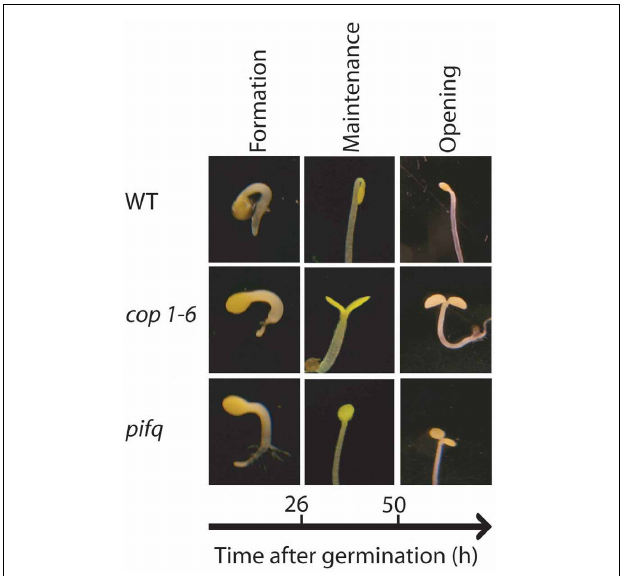
FIGURE 1 | Apical hook development in dark grown seedlings requires the repressors of photomorphogenesis COP1 and PIFs. Representative photographs of the apical section of the hypocotyls of WT Col, cop1-6 and pifq mutants during the three phases of hook development. Photographs were taken 24h after germination for the formation phase, 48h after germination for the maintenance phase and 84h after germination for the opening phase.